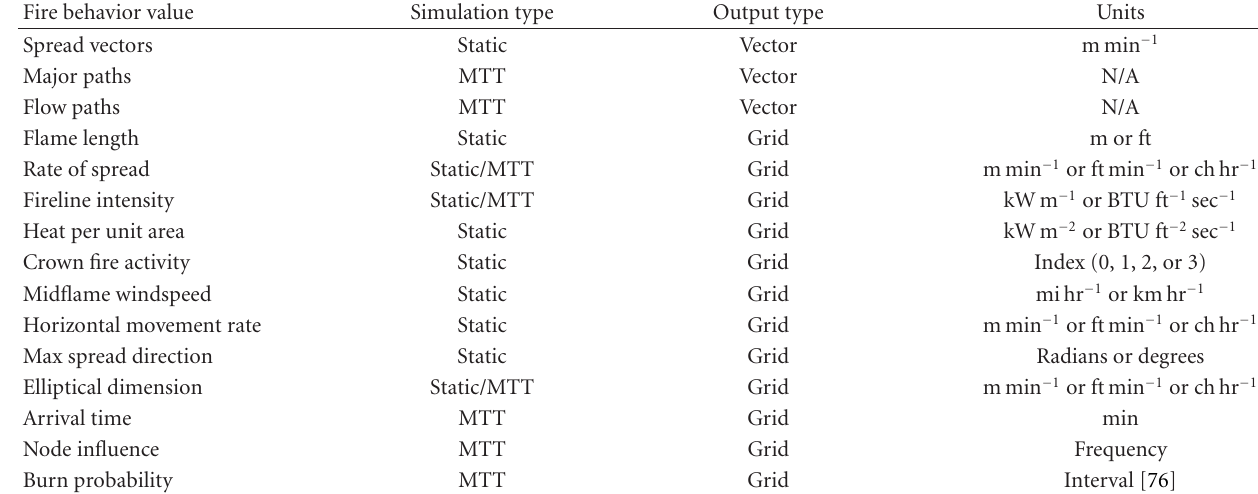
Table 2: Fire behavior output variables from FlamMap for a static simulation where fire is simulated for all pixels on the input landscape file.